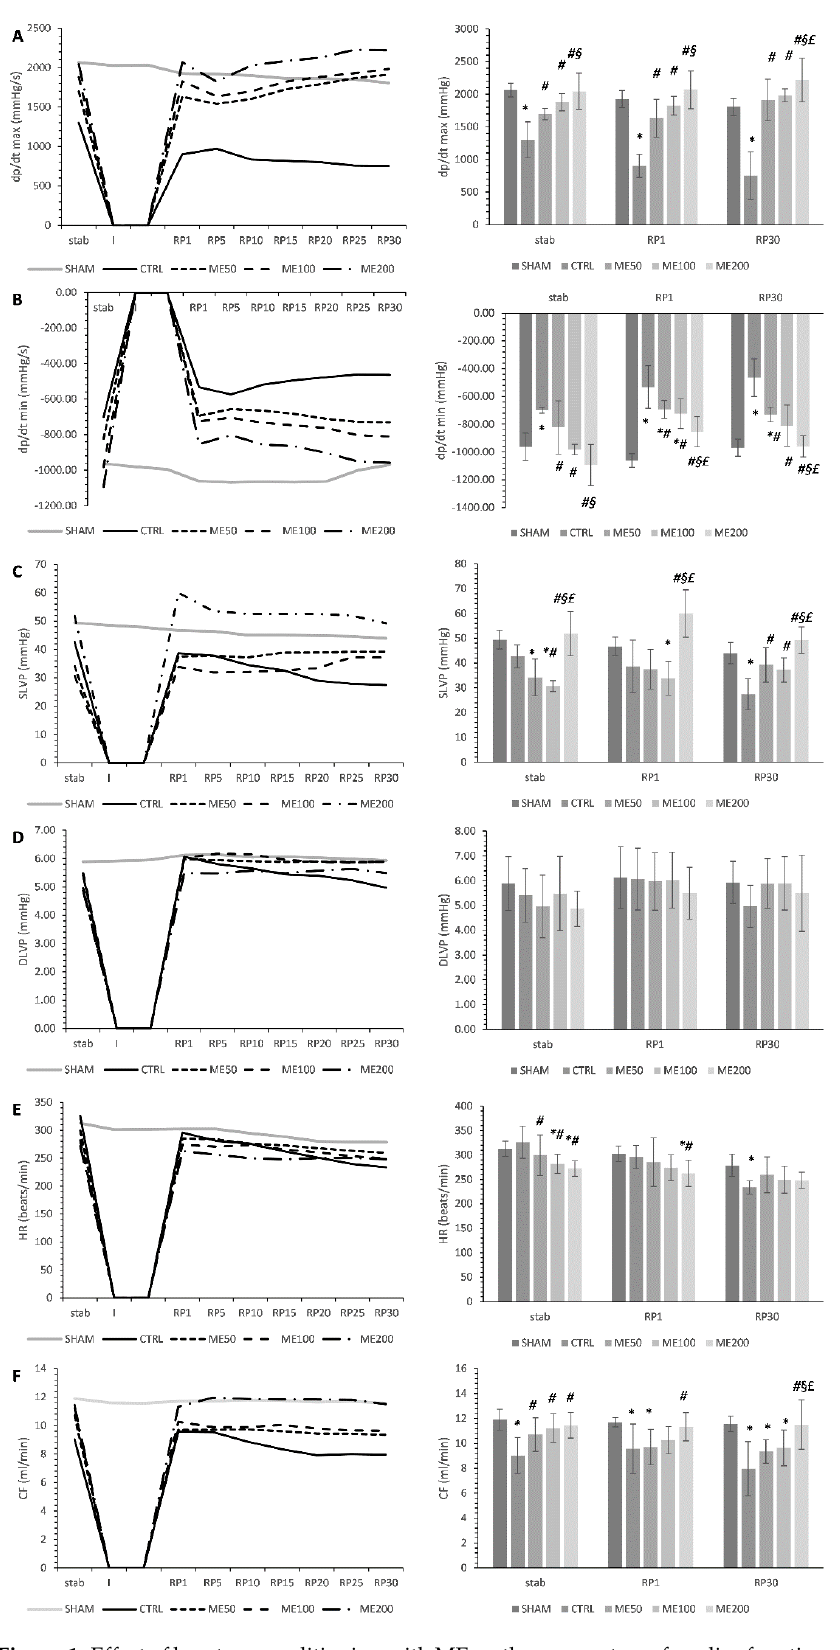
Figure 1. Effect of heart preconditioning with ME on the parameters of cardiac function. ( A ) Maximum rate of left ventricle pressure development − dp/dt max; ( B ) minimum rate of left ventricle